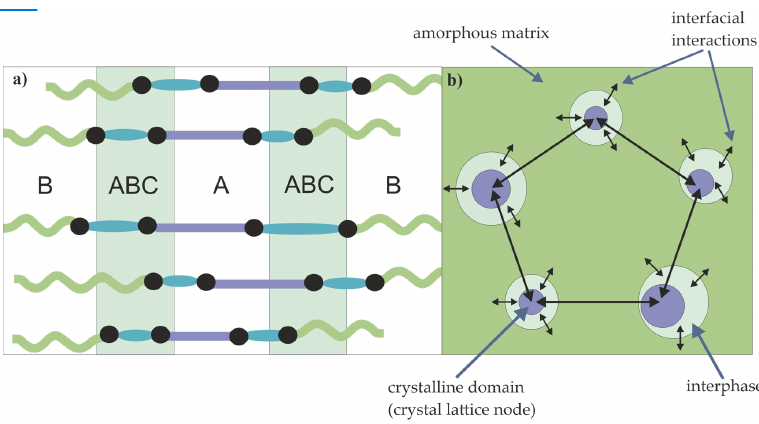
Figure 20. Predicted structure of TPEs; ( a ) phase composition: A—PA12, B—PTMO or DLAol, C—xGT; ( b ) physical structure.